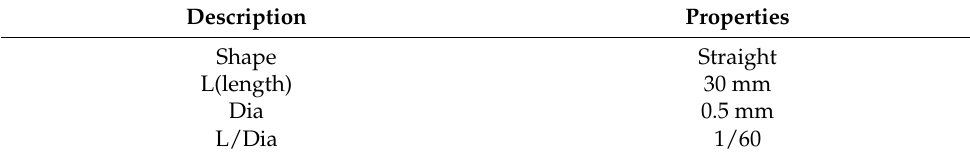
Table 3. Properties of steel